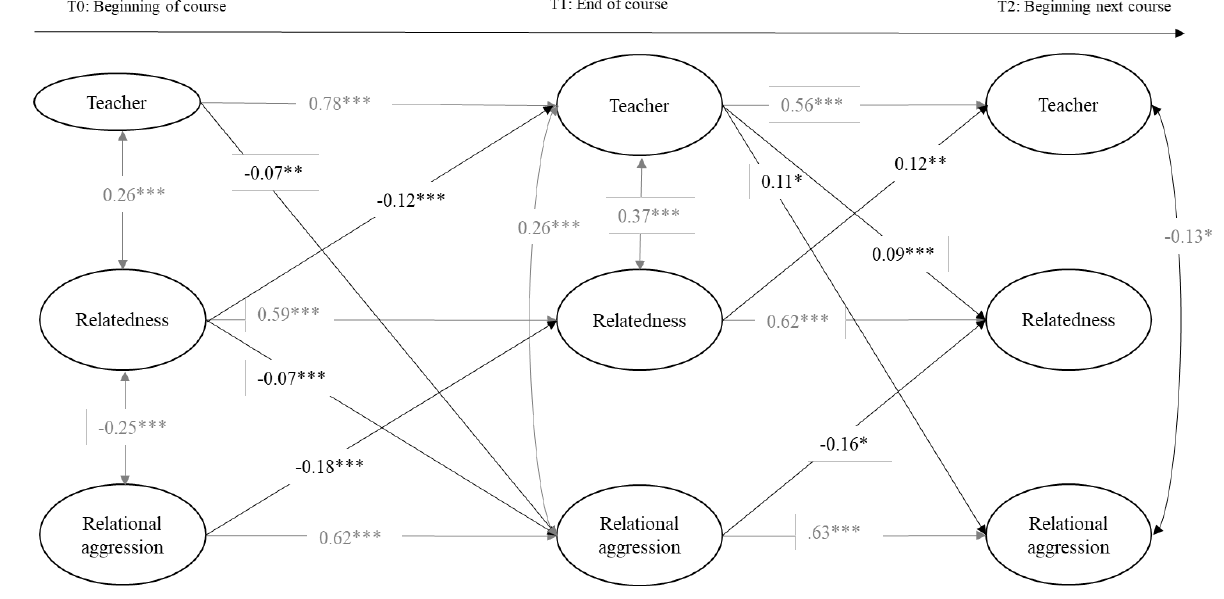
Figure 4. Cross-lagged model predicting longitudinal reciprocal relations between teacher support, relatedness, and rela- tional aggression in boys. Only estimates significant at p < 0.05 or less are provided. Cross-lagged paths are depicted in bold. * p < 0.05. ** p < 0.01. *** p < 0.001.